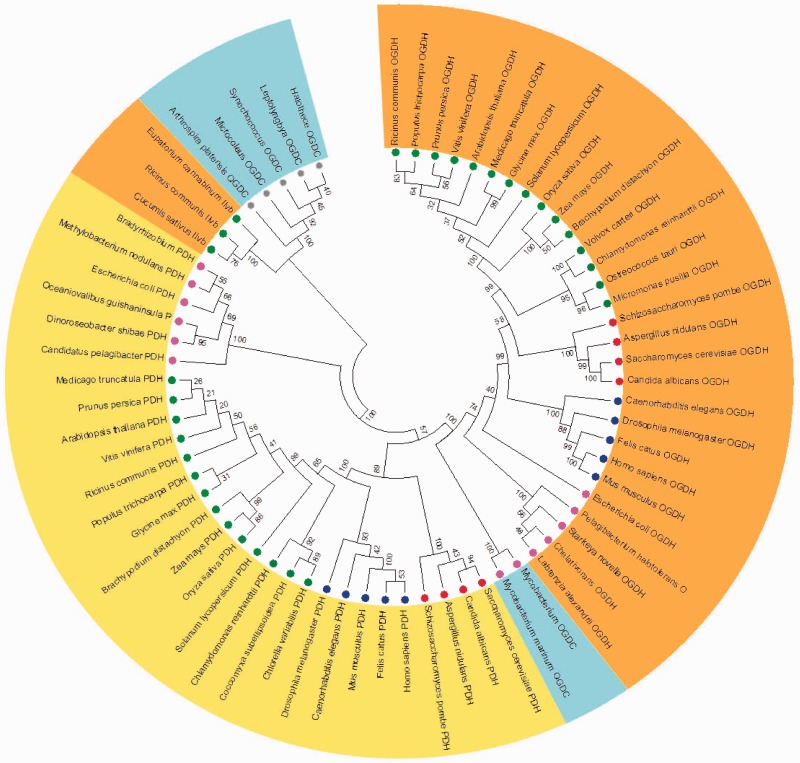
The distinct phylogeny of OGDH, PDH, OGDC, and OGDC. Phylogenetic tree was built using putative amino acids sequences from OGDH (orange background), PDH (yellow background), OGDC (blue background), and OGDC from cyanobacteria (green background) and acetolactate synthase. Sequences of putative proteins from plants are highlighted by green circle, yeast by red circle, animals by blue circle, algae by dark green circle, bacteria by pink circle, and cyanobacteria by gray cycle.